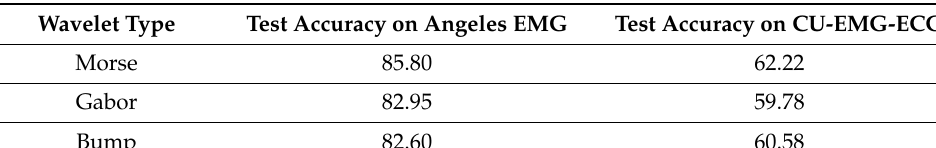
Table 3. Accuracies on Test data according to wavelet type.